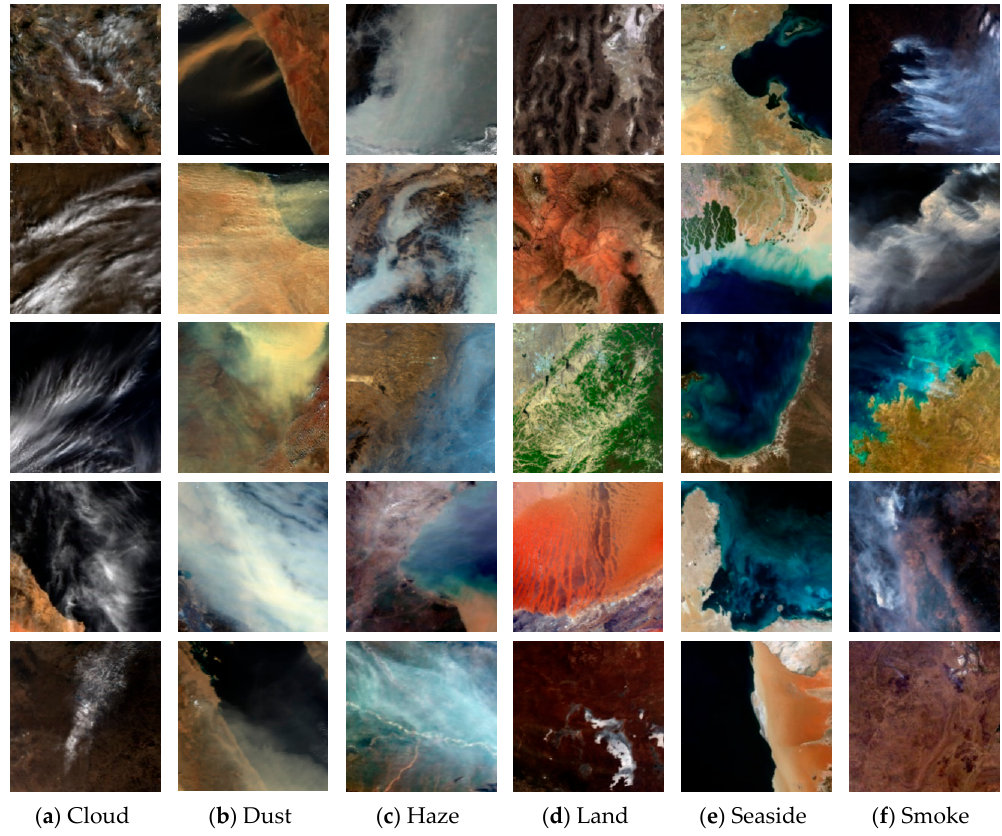
Figure 2. Example images of the six classes in the USTC_SmokeRS dataset. The images in the first column to the sixth column belong to Cloud, Dust, Haze, Land, Seaside, and Smoke,